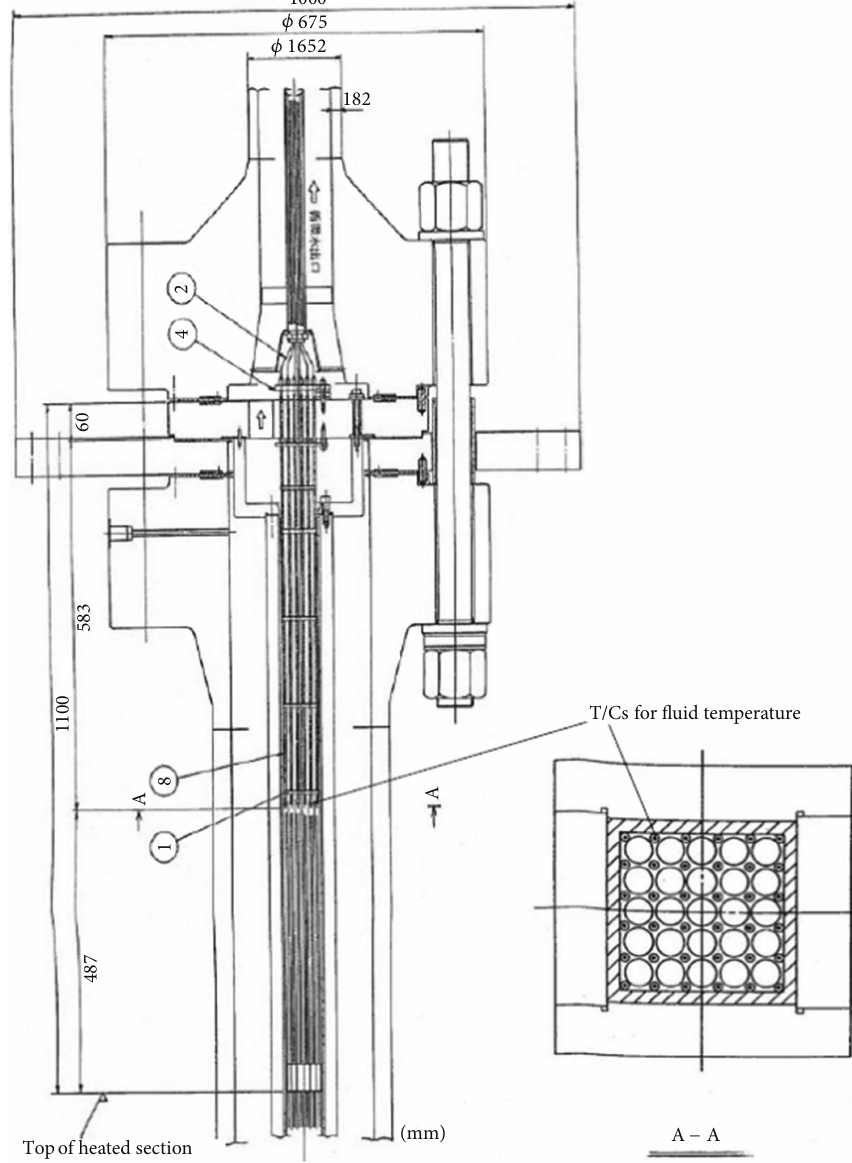
Figure 14: Diagram of fluid temperature measurement